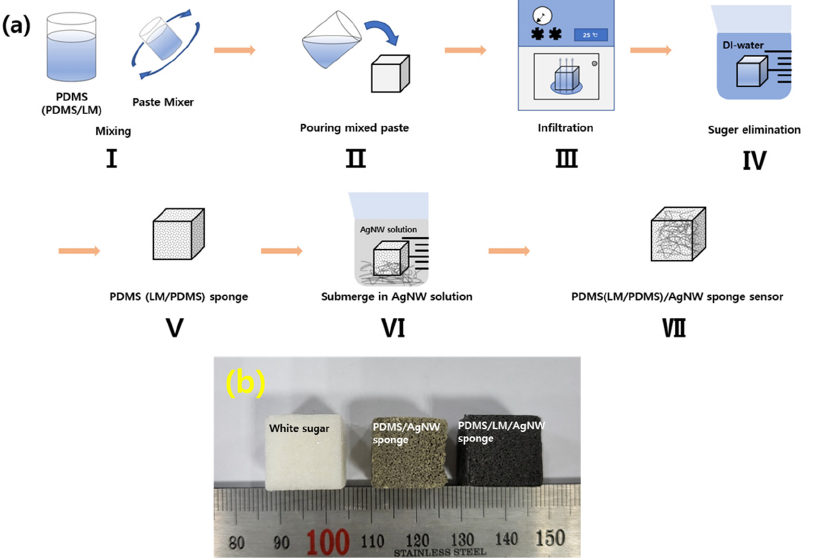
Figure 1. Soft multifunctional polydimethylsiloxane (PDMS)/silver nanowire (AgNW) and liquid metal (LM)/PDMS/AgNW porous sponge sensors. ( a ) Schematic illustration of fabrication of sponge sensor; ( b ) images of white sugar cube, PDMS/AgNW sponge, and PDMS/LM/AgNW sponge.